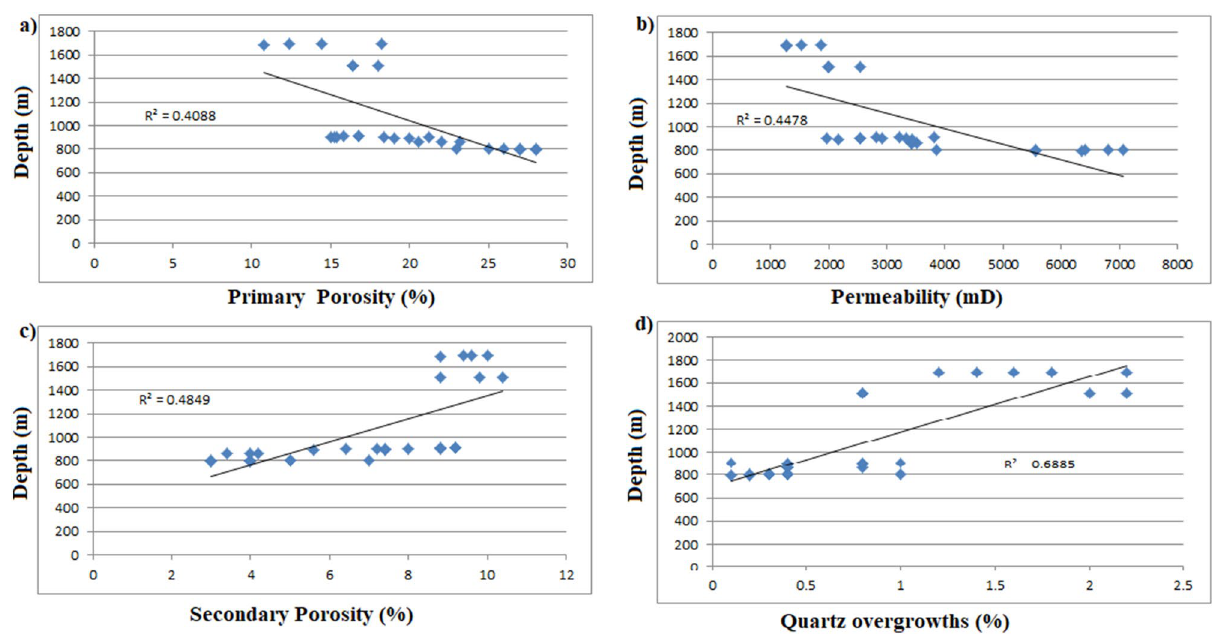
Figure 12. ( a ) Cross- plots of primary porosity and permeability values against depth of burial ( b ) Porosity and permeability decrease with increasing burial depth. ( c ); Secondary porosity displaying a positive trend amidst increasing burial depth. ( d ); Quantity of quartz overgrowths increasing with increasing burial